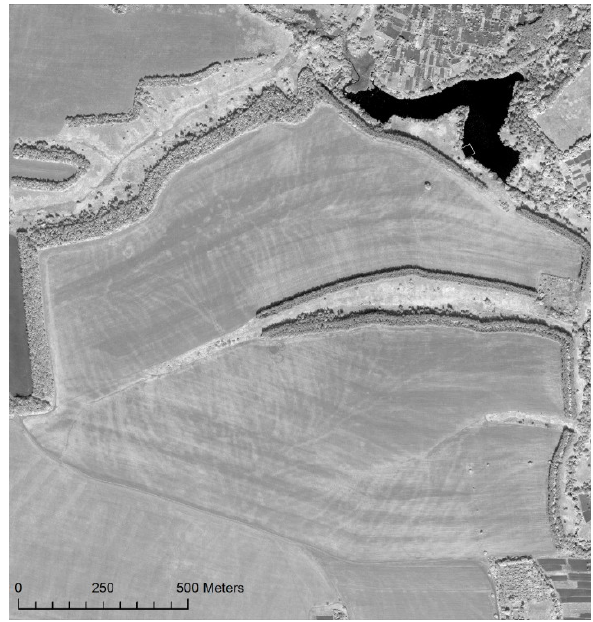
Figure 1. Satellite image of the study area (courtesy of the DigitalGlobe